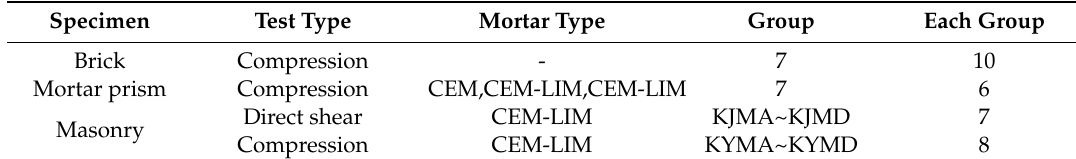
Table 5. Number of samples and testing conditions for the samples.